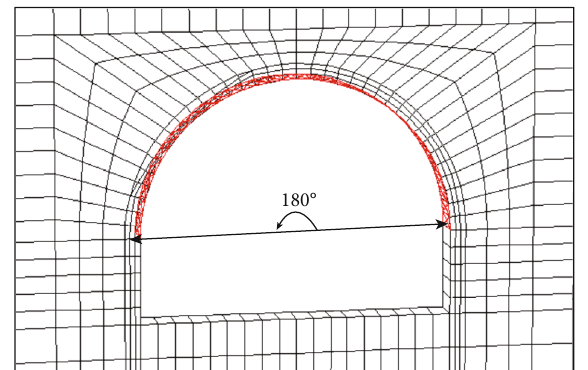
Figure 3: Reinforcing region with the FRP-PCM method.